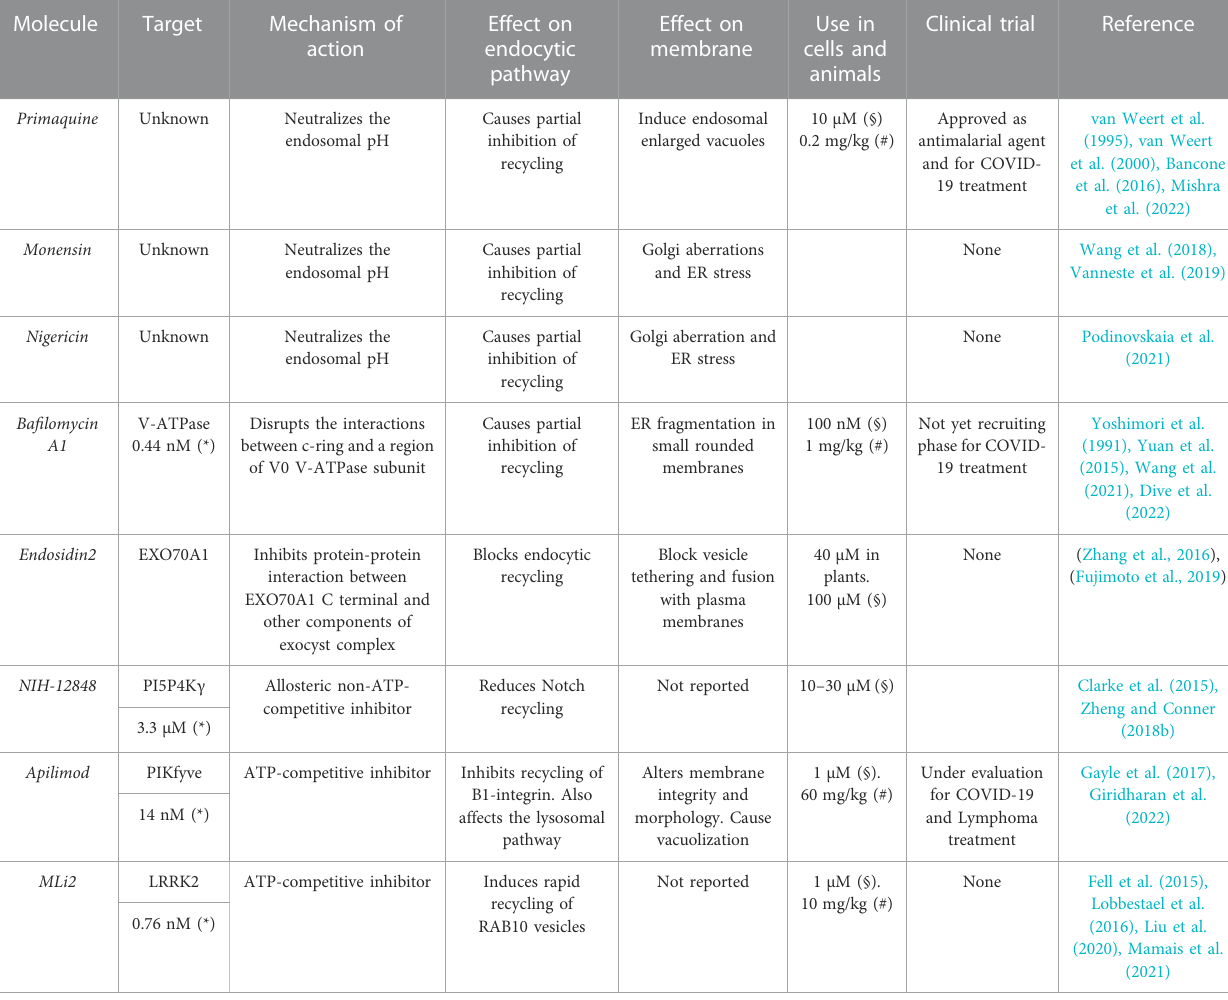
TABLE 2 Small molecules inhibitors targeting speci fi c recycling